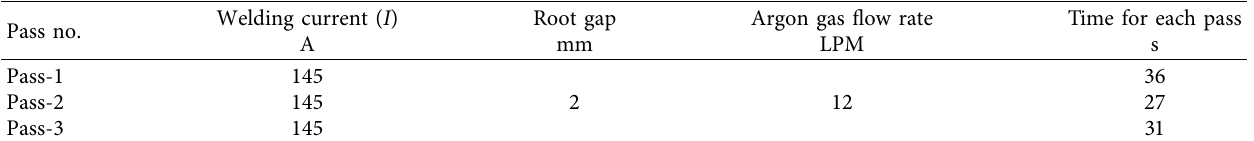
Table 1: Multi-pass welding process